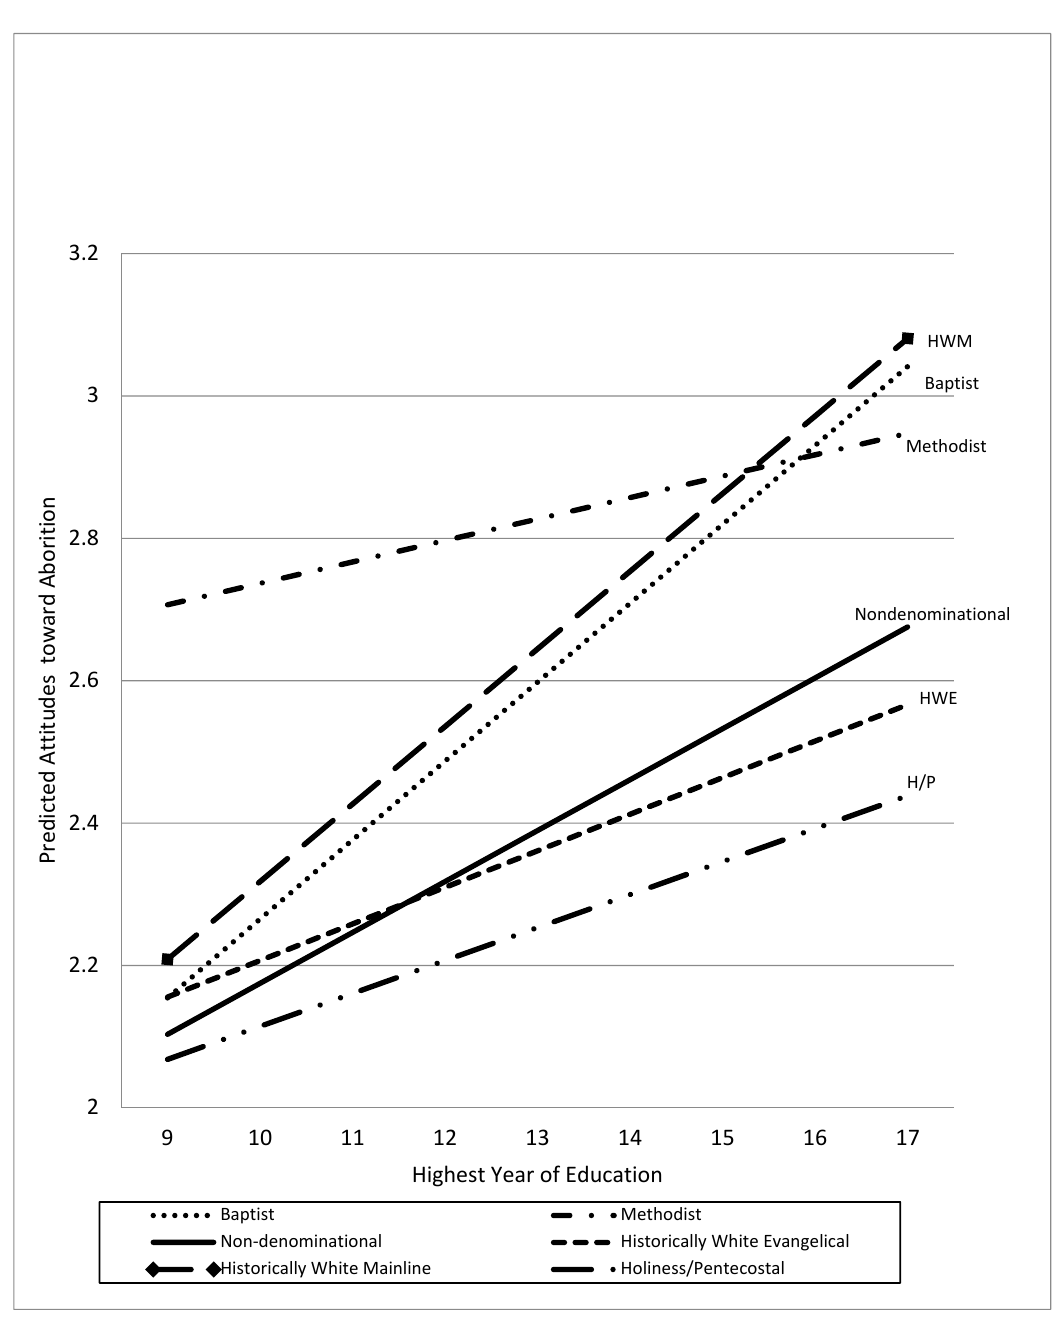
Figure 9. The interaction of education and religion for Black Protestant views on abortion.